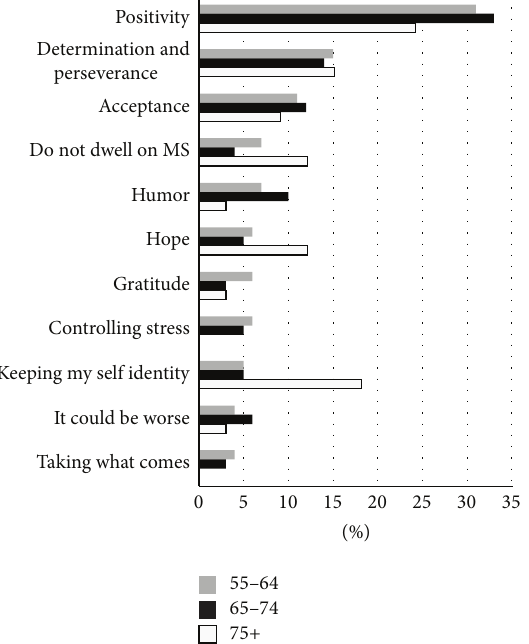
Figure 2: Age stratification of attitude and outlook subthemes. The figure displays the average frequency of each subtheme by age category. “Keeping my self-identity” is notably more prominent among those aged 75 and older.